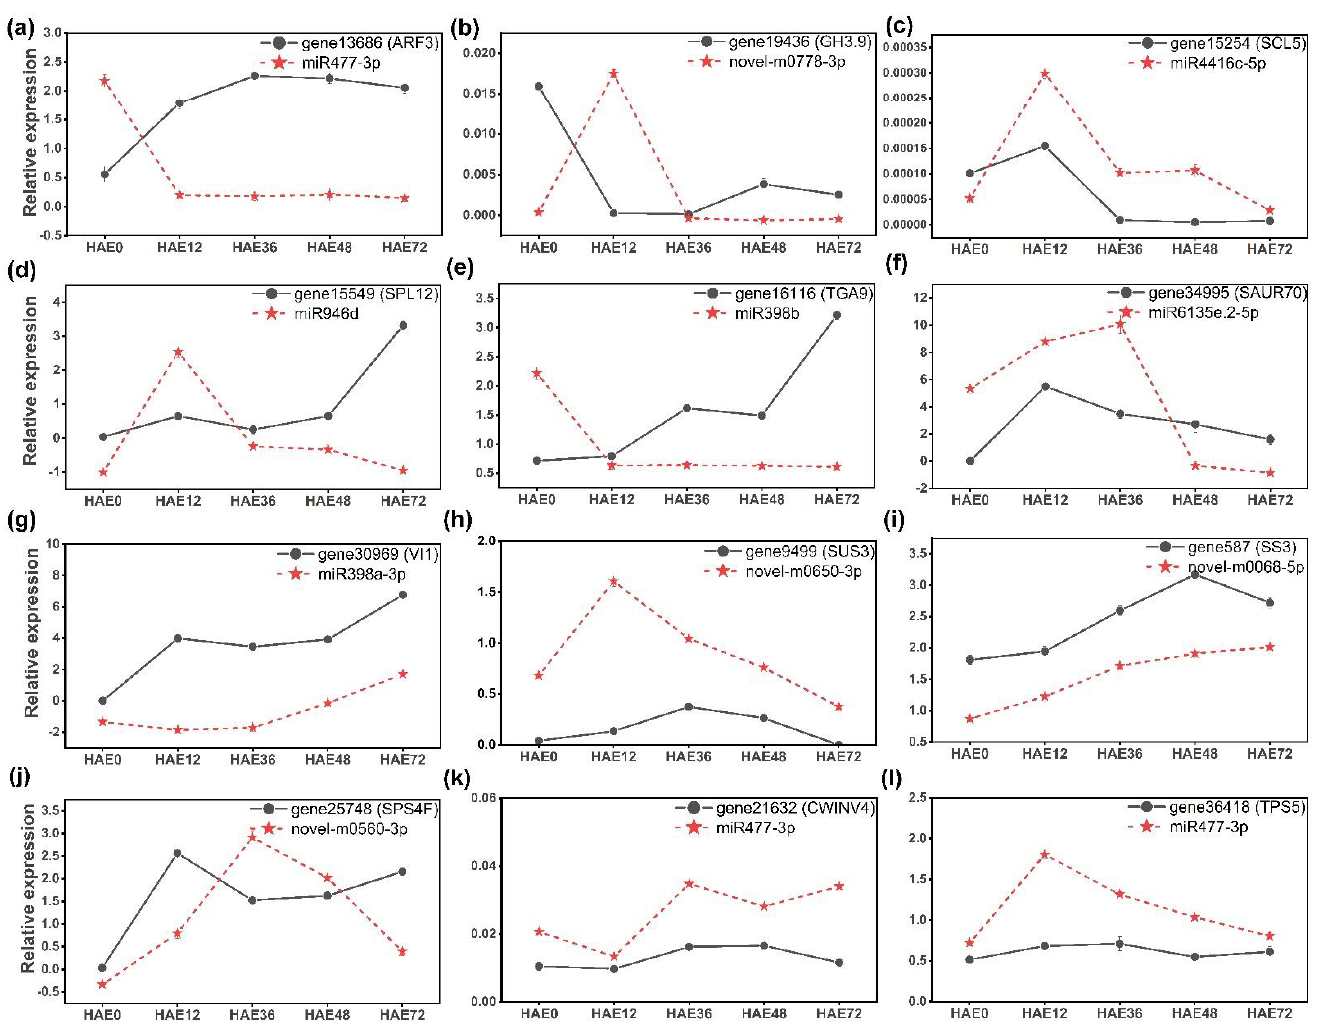
Figure 7. Expression analysis of ten miRNAs and their twelve target genes obtained from dark- pretreated micro-shoot cuttings of tetraploid R. pseudoacacia L. at 0, 12, 36, 48, and 72 HAE. ( a – f ) The genes and their respective miRNA expression during the auxin signaling pathways. ( g – l ) The genes and their respective miRNA expression during the starch and sucrose metabolism pathway. The data presented are an average of three technical replicates.